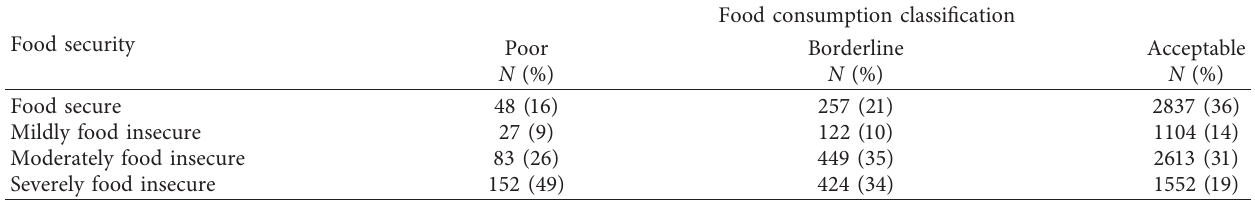
Table 9: Percentage contribution of each food group to the household total energy intake by food security. Food